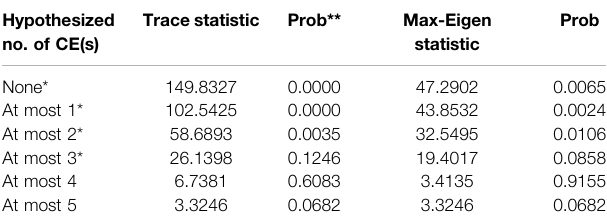
TABLE 5 | Results of Johansen cointegration